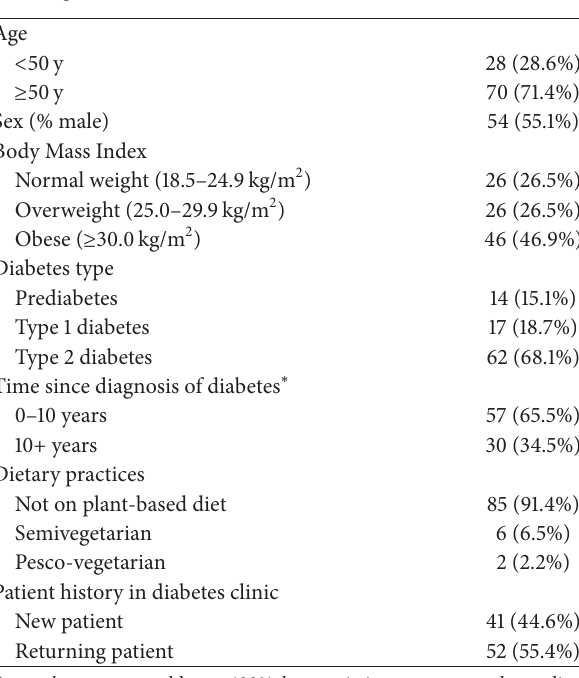
Table 1: Knowledge and perception of plant-based diets in patients attending a Diabetes Education Centre.